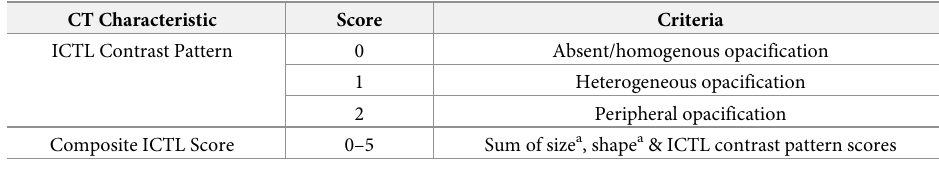
Table 2. Criteria used to classify cervical LNs from dogs with oral tumors from ICTL